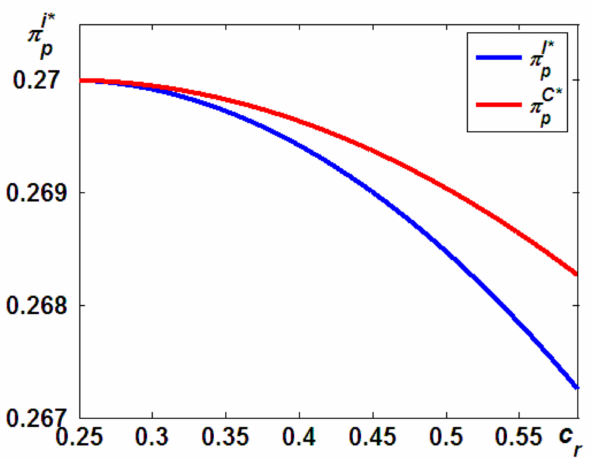
Figure 5. Differences in the IR’s